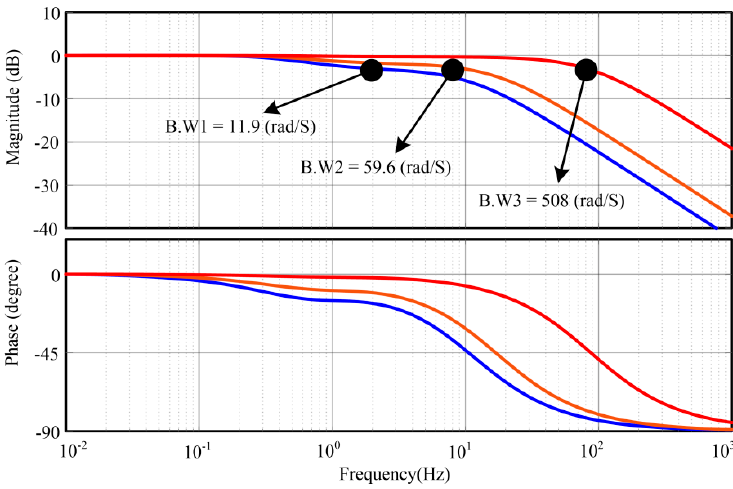
Figure 15. The closed-loop frequency response of improved PLL.